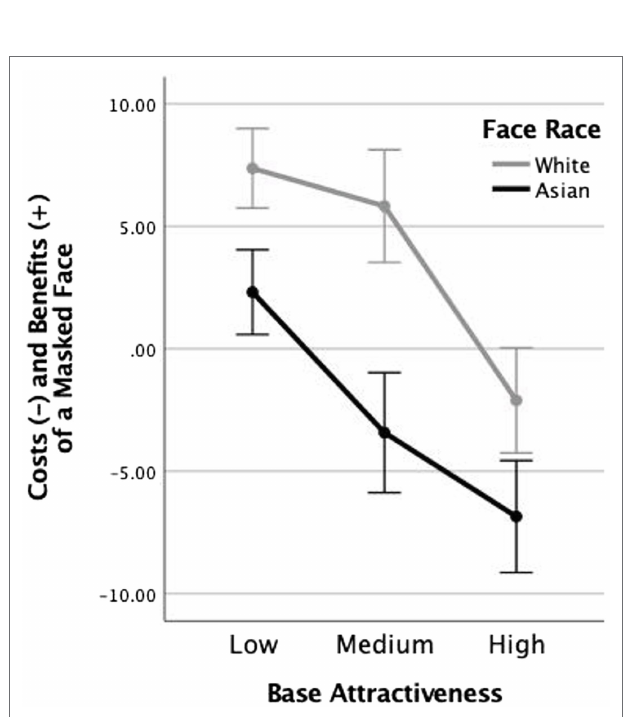
FIGURE 3 | Mean difference scores show the difference between ratings for masked and unmasked faces, across the three levels of baseline attractiveness and two races. The difference scores were calculated for each participant as the difference between ratings for masked and unmasked faces. Error bars represent +/ − 1 standard